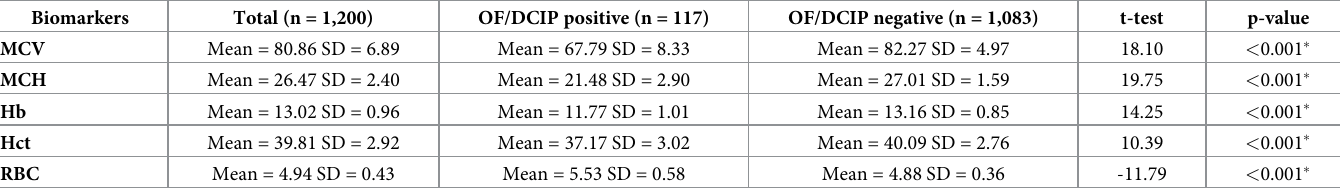
Table 3. Comparisons of mean MCV, MCH, Hb and Hct levels between thalassemia carriers and nonthalassemia carriers.